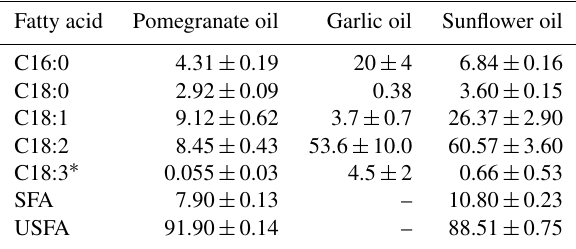
Table 2. Fatty acid (FA) profile of the experimental oils (% FA in total fatty acid content; mean ±